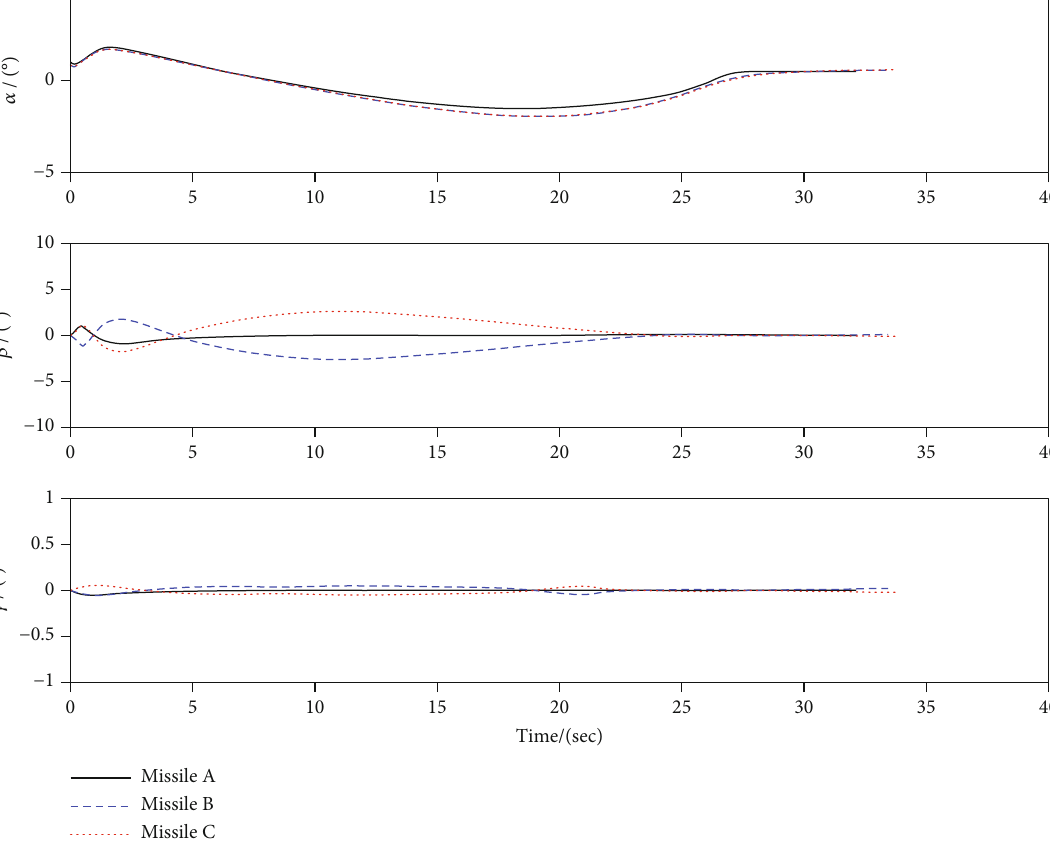
Figure 6: Response curves of the attack angle, sideslip angle, and roll angle of three